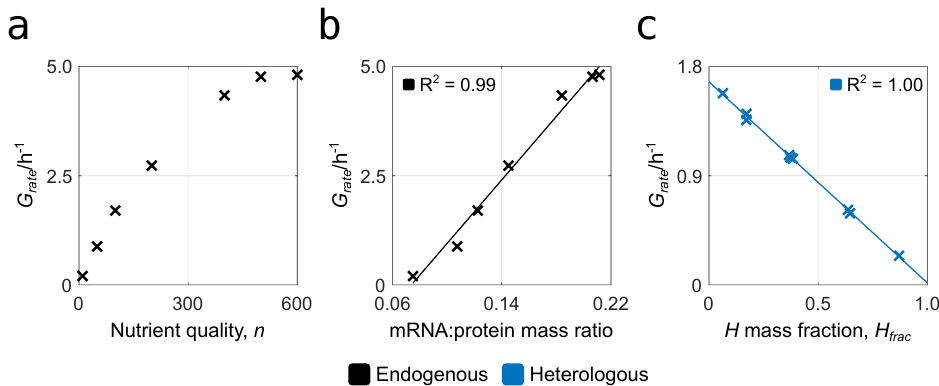
Figure 4. Characterising StoCellAtor’s behaviour in both endogenous and heterologous simulations. ( a ) Recovering Monod’s law: the hyperbolic dependency between external nutrient quality and growth rate. ( b ) Recovering Schaechter’s law: the linear relationship between growth rate and the mRNA:protein mass ratio. A different value of nutrient quality (corresponding to the values in subfigure a) is used for each data point. ( c ) Recovering the linear relationship between G rate and H frac that was experimentally observed in [3]. For each data point, different combinations of promoter and RBS strengths are considered (see Section 3.2), while the nutrient quality parameter is fixed to n = 100. A linear regression with corresponding R 2 values is also